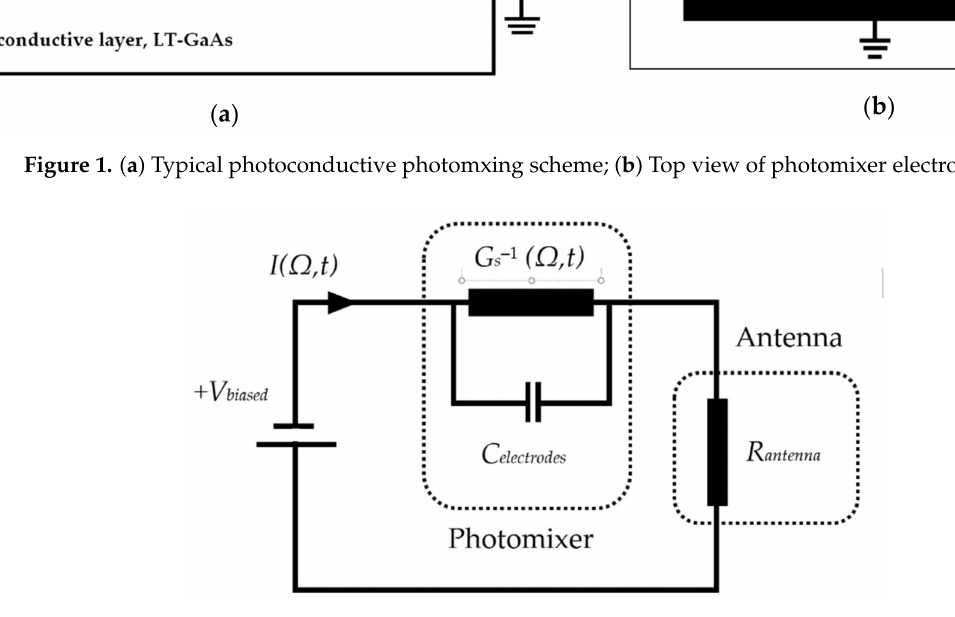
Figure 2. Equivalent circuit of photomixer based THz